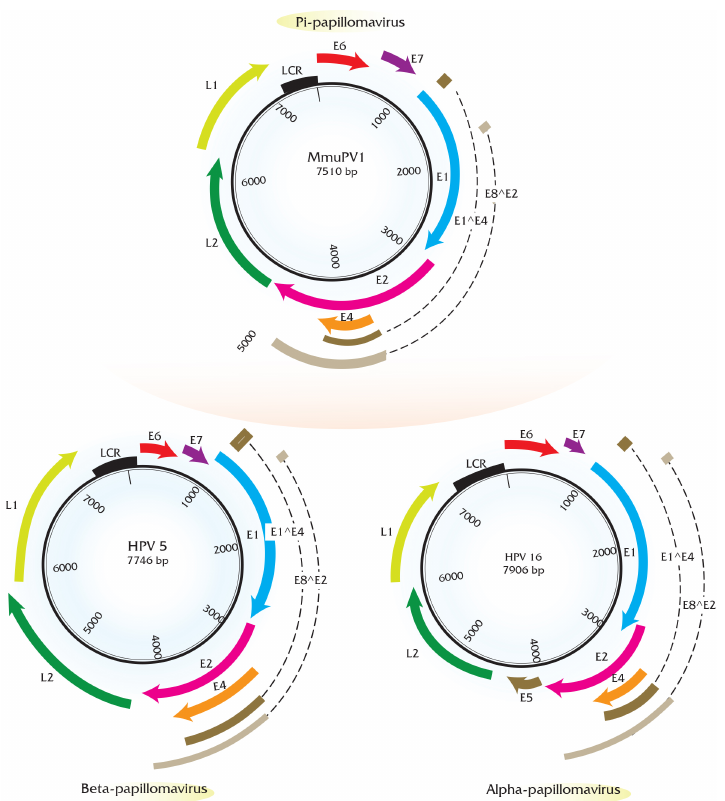
Figure 1. Genome organization of rodent papillomaviruses compared to high-risk papillomaviruses. Rodent PVs follow similar genome organization as prototype papillomaviruses and contain early and late open reading frames (ORFs). Shown here is the mouse papillomavirus (MmuPV1) genome ( top ) as an example of rodent papillomaviruses. For comparison, genomes of prototype high-risk HPVs i.e., HPV5 ( bottom left , cutaneous Human Papillomavirus (HPV) as an example of beta-papillomaviruses) and HPV16 ( bottom right , mucosal HPV as an example of alpha papillomaviruses) have been shown. The early ORF of MmuPV1 and HPV5 consists of E1 (blue), E2 (pink), E4 (orange), E6 (red) and E7 (purple) and the late ORF consists of L2 (green), L1 (lime). At the genomic level, the most notable change in rodent PV organization compared to HPV16 is the lack of E5 oncogene (brown), which is present in HPV16. Genes E5 , E6 , E7 have been shown to be oncogenic in the context of several papillomaviruses. The long control region (LCR) is shown in black. E1^E4 (dark brown) and E8^E2 (light brown) splice products are also indicated based on transcript maps of these